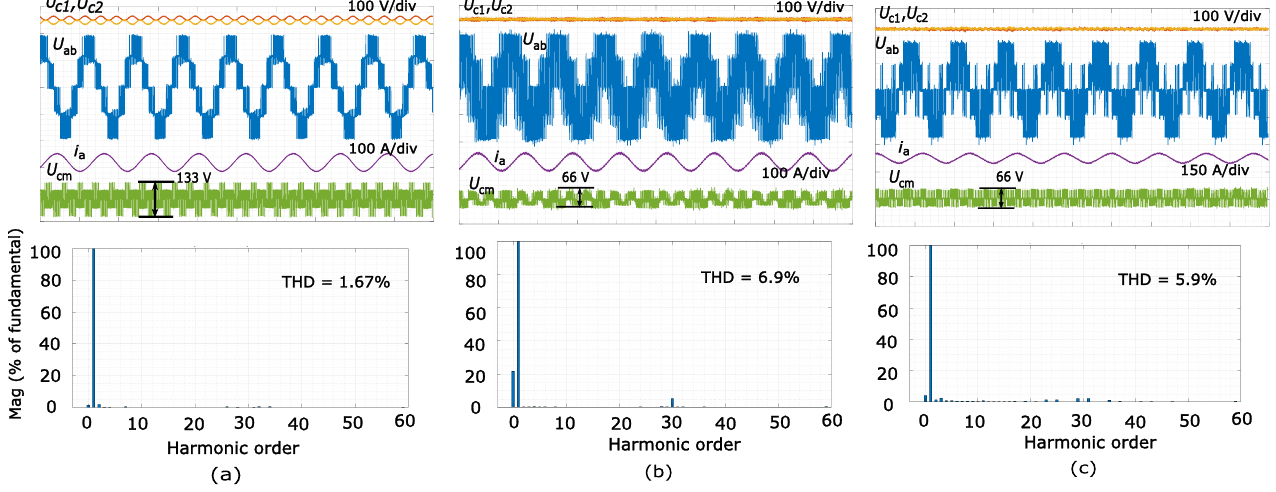
Figure 18. Measured line-to-line voltage, DC-link capacitor voltages, output current i a , common- mode voltage U cm , and harmonic content for Case II; ( a ) conventional CBPWM, ( b ) RCMV-CBPWM where only phase a is reversed, ( c ) proposed RCMV-CBPWM.